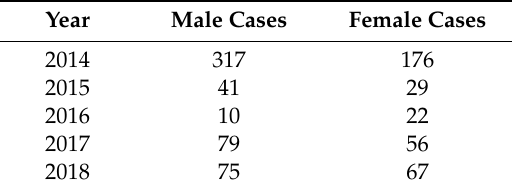
Table 2. Gender distribution of domestic imported dengue fever from 2014–2018.